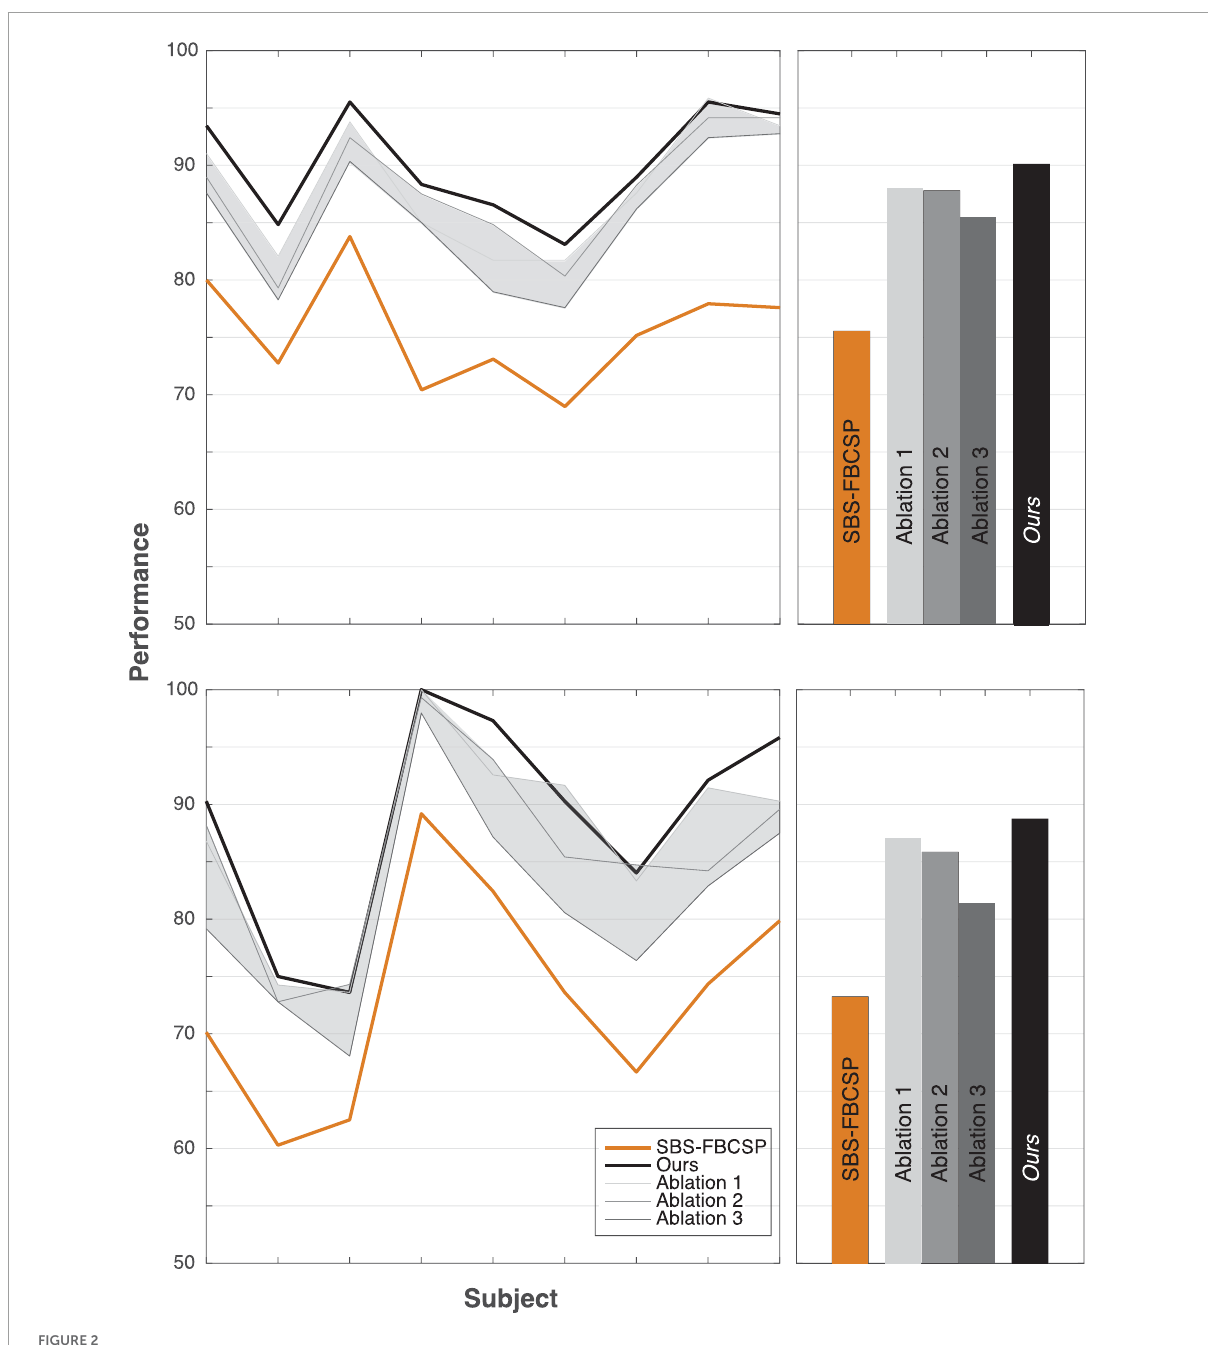
FIGURE2 Ablation tests. Reducing the number of features as ablation tests for dataset 1 (top row) and dataset 2 (bottom row) . The shaded areas depict the range of performance for all nine subjects across all ablation tests, with the three tests showing the extremal performance highlighted individually as “Ablation #.” Right panels show the average performance across all subjects. “Ablation 1” corresponds to a test that included all five time windows (500–4,500 ms range, with 2 s windows size, and 500 ms step size) and 12 frequency bands (4–30 Hz range, with 4 Hz window size, and 2 Hz step size) for a total of 60 input features (12 bands × 5 time windows) reduced gradually to 10 features through the selection. “Ablation 2” corresponds to a test with three time windows (500–3,500 ms range, with 2 s windows size, and 500 ms step size) and 17 frequency bands (4–40 Hz range, with 4 Hz window size, and 2 Hz step size) for a total of 51 input features (17 bands × 3 time windows) reduced gradually to 10 features through the selection. “Ablation 3” corresponds to a test with three time windows (500–3,500 ms range, with 2 s windows size, and 500 ms step size) and 12 frequency bands (4–30 Hz range, with 4 Hz window size, and 2 Hz step size) for a total of 36 input features (12 bands × 3 time windows) reduced gradually to 10 features through the